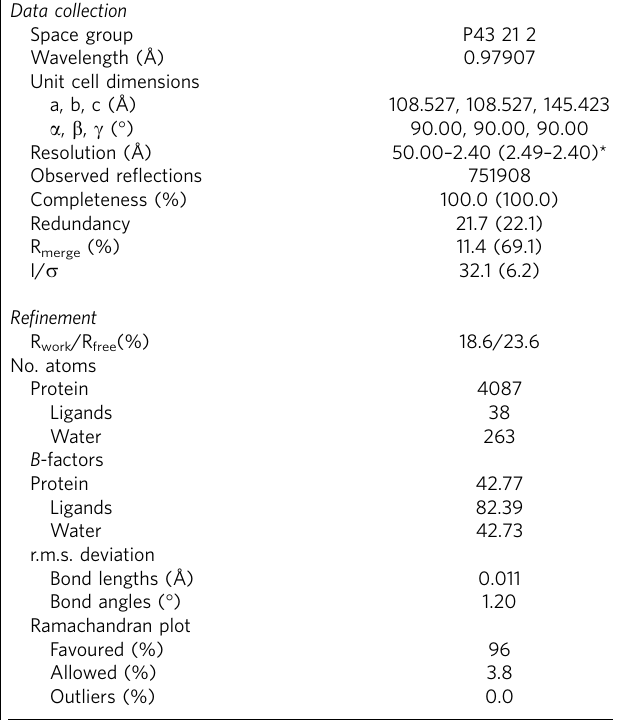
Table 1 | Data collection and refinement statistics. Data collection Space